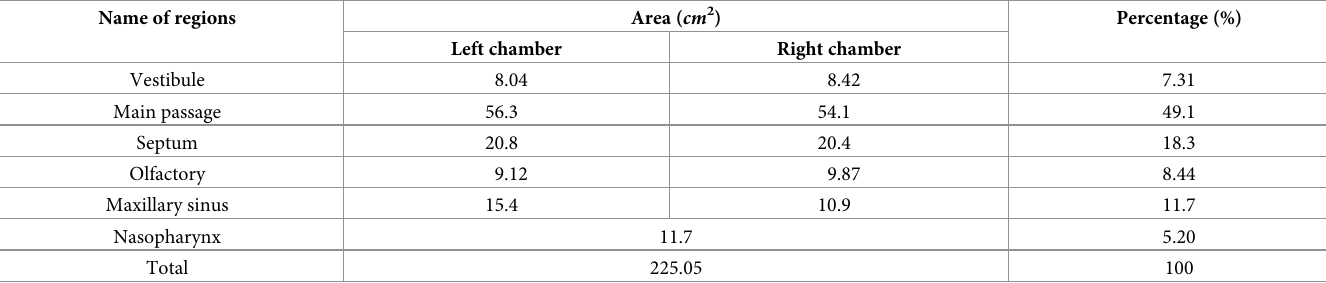
Table 1. Geometrical information of major anatomical regions.